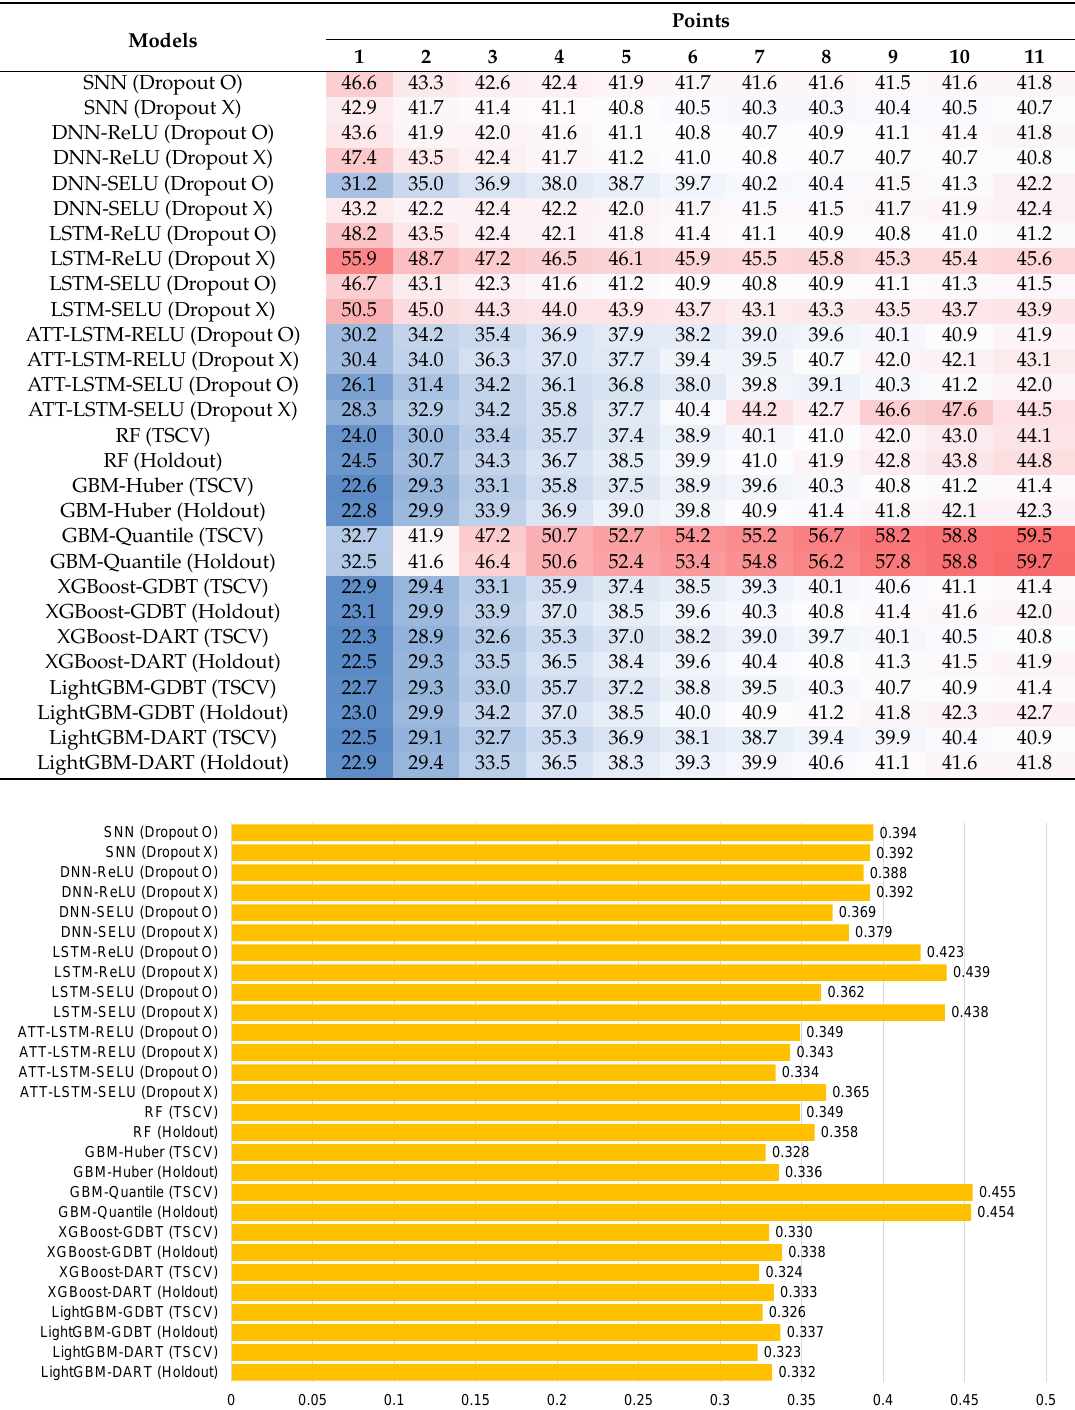
Table 8. Normalized root mean square error (NRMSE) distribution for each model for Ildo-1. A cooler color indicates a lower NRMSE value, whereas a warmer color indicates a higher NRMSE value (%). Models